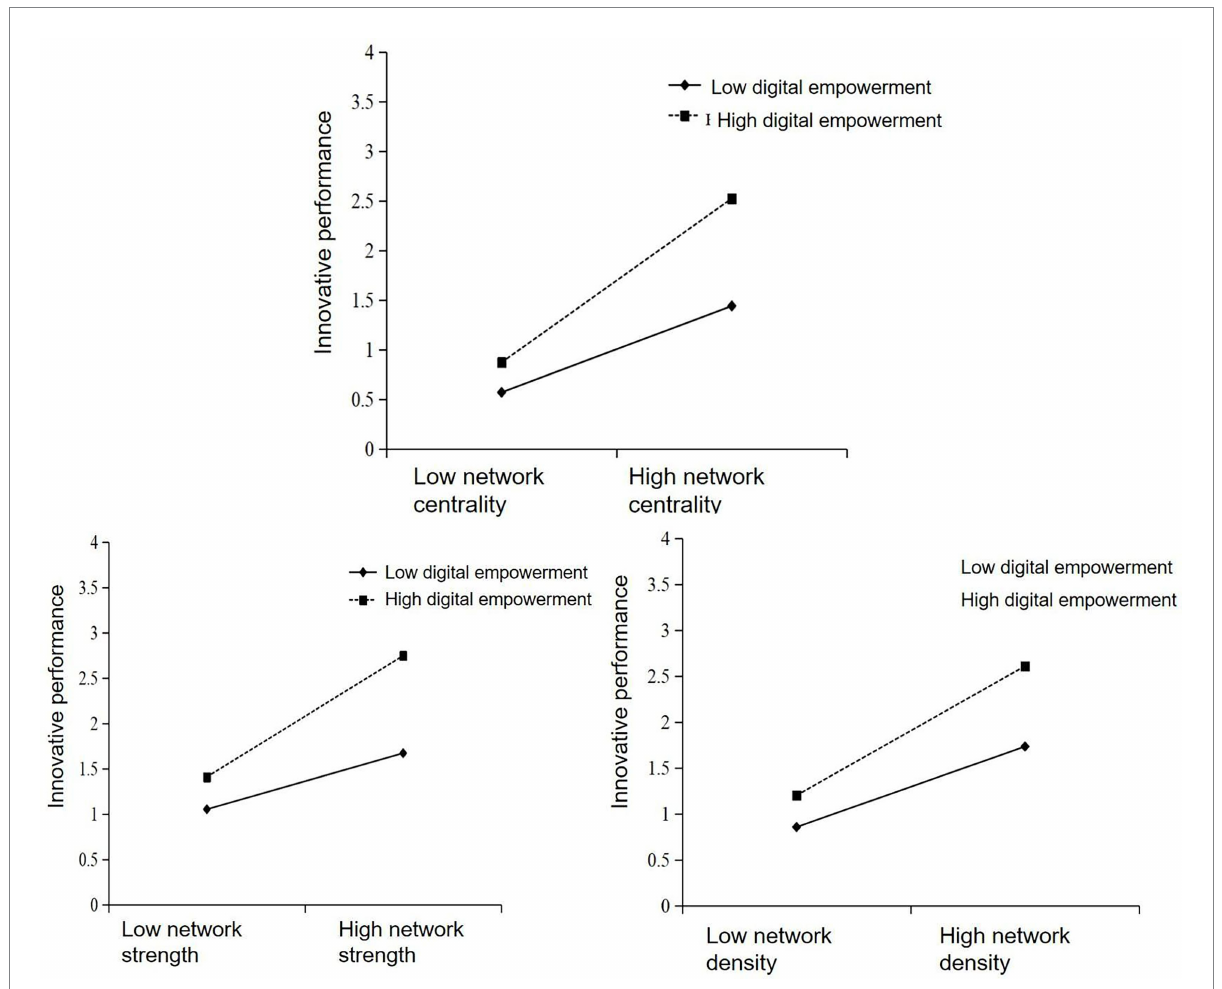
FIGURE 4 Digital empowerment regulating innovation network and innovation